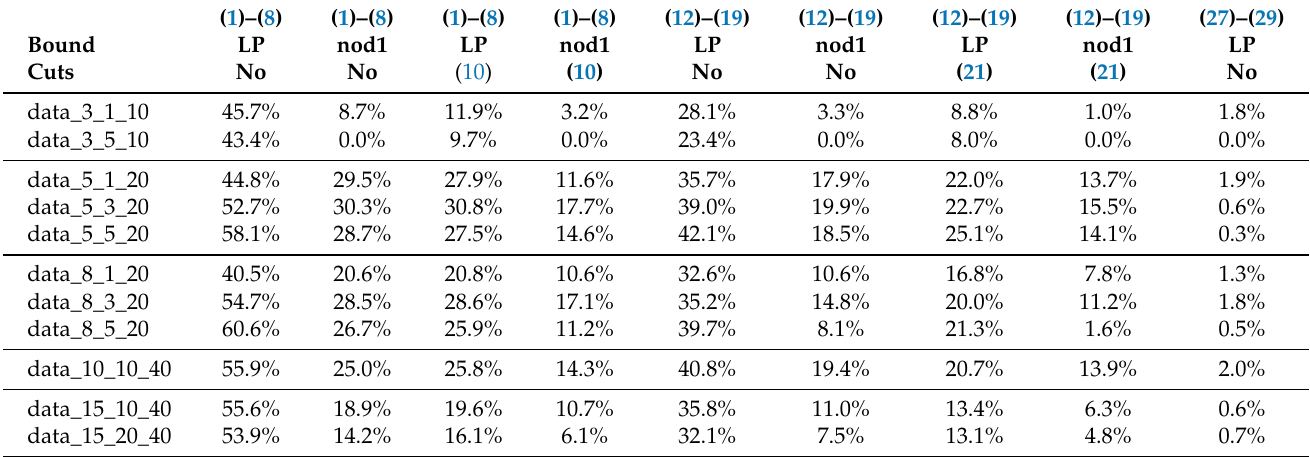
Table 2. Comparison of the average gaps to dual bounds given by some variants of MILP formulations to the optimal solutions on a set of 55 instances solvable to optimality with Cplex. The results are gathered on instances with the same number of technicians, skills and interventions. LP denotes the linear relaxation, whereas nod1 denotes the bounds obtained after the cutting plane passes of Cplex at the root node before